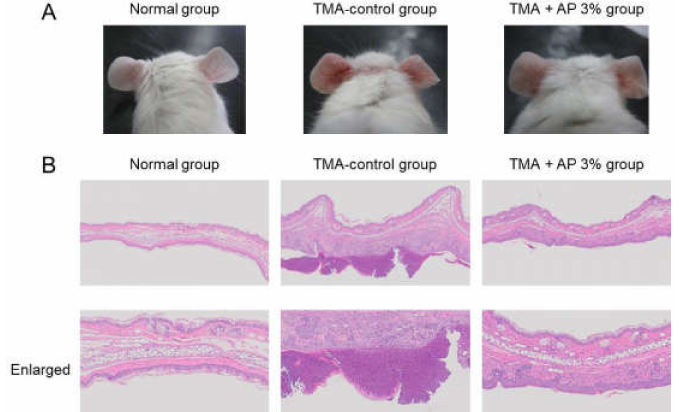
Figure 3. Skin inflammation. Mice with atopic dermatitis induced by repeated application of TMA were given a diet with AP. Clinical features of skin were observed ( A ). Skin tissue was assessed by HE staining ( B